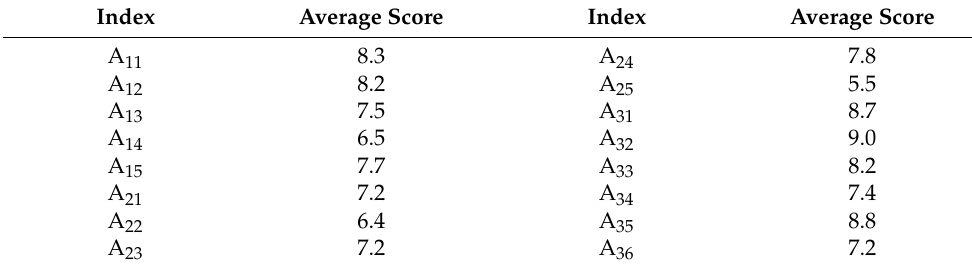
Table 4. Average score of each indicator.